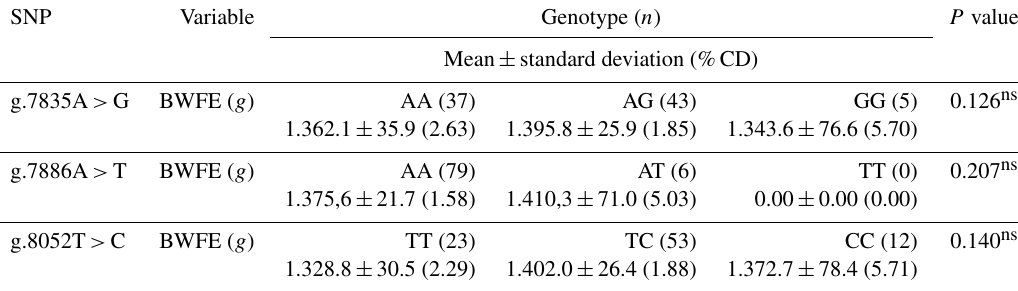
Table 3. Association of the prolactin SNP gene with body weight first on egg in IPB-D1